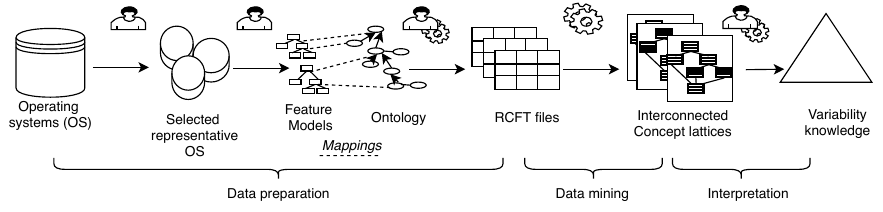
Figure 1. Outline of our implemented KD